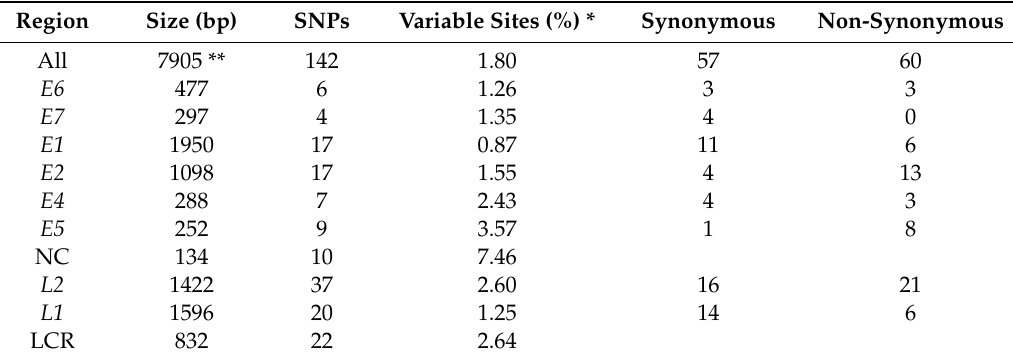
Table 3. SNPs detected in Japanese A4 isolates ( n = 52).